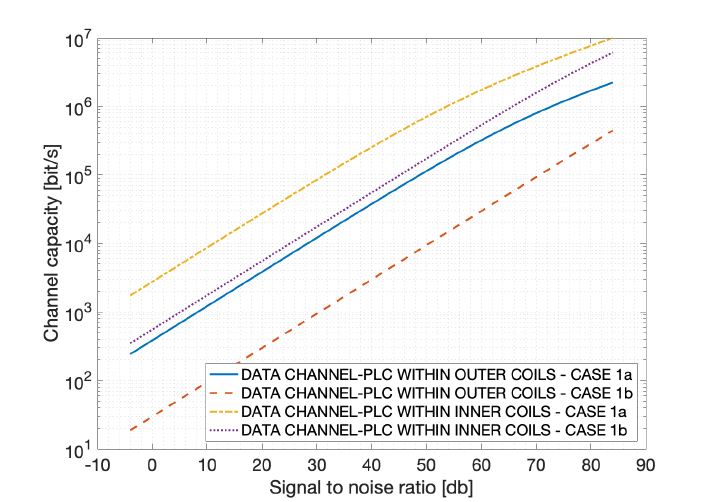
Figure 13. Channel capacity comparison, Case Study